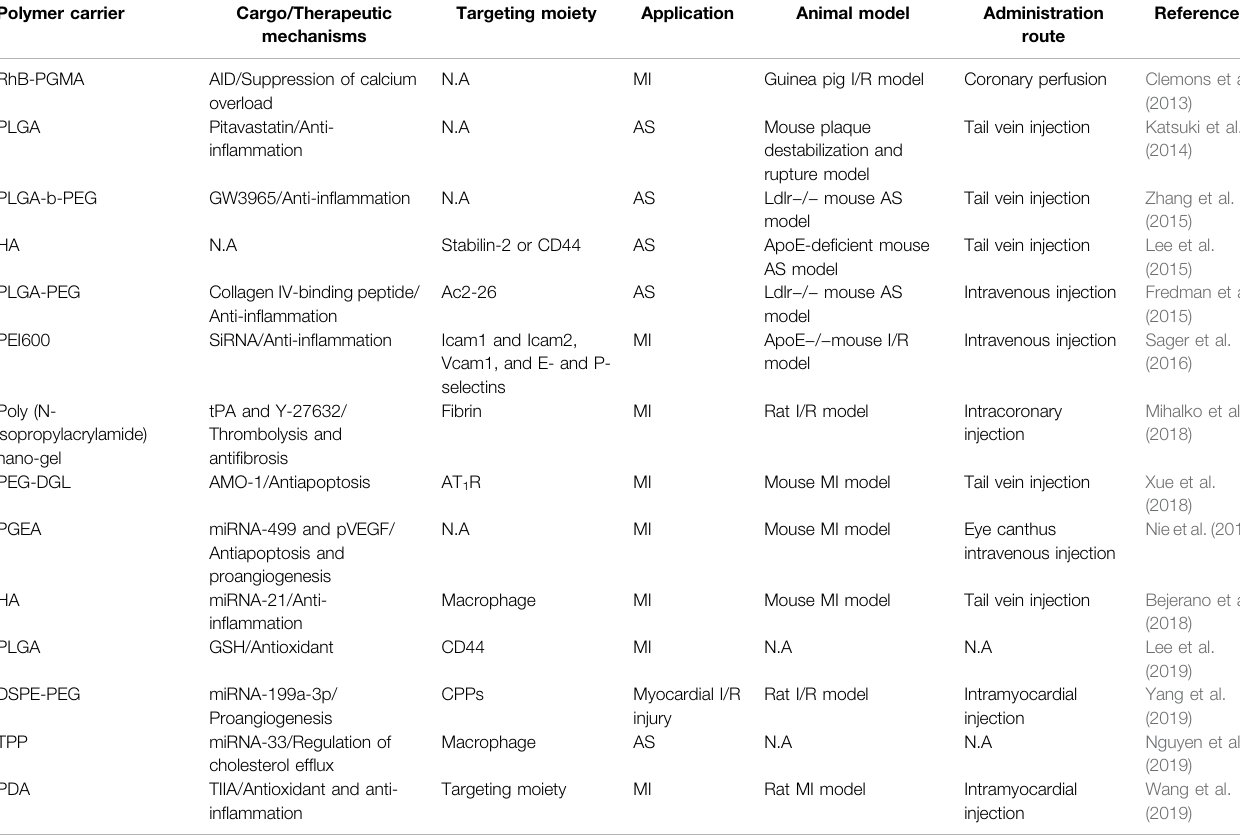
TABLE 2 | Summary of the polymer NPs for drug delivery in treating ASCVD. Polymer